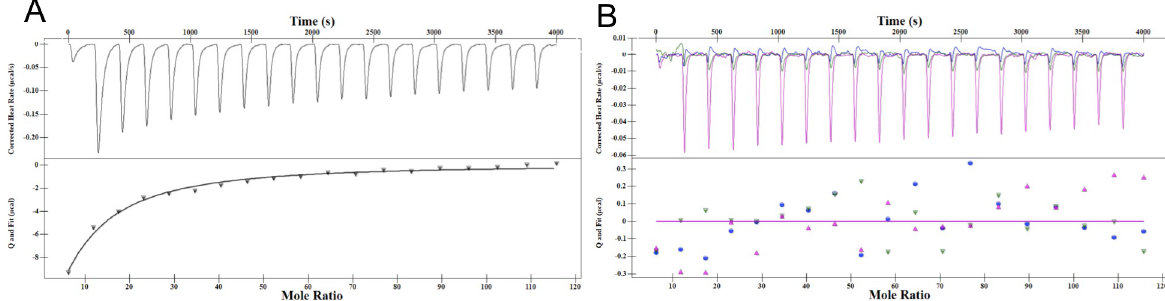
Fig 7. Microscale isothermal calorimetry indicates EfgA binds formaldehyde but not methanol, formate, or acetaldehyde. The binding isotherms represented as heat change ( μ J/s) upon injection over time are in the top portion of the split graph, with independent binding modeling on the bottom portion. (A) Binding observed with 50 μ M EfgA (black) and 2 μ L injections of 25 mM formaldehyde (in PBS). (B) Binding observed with 50 μ M EfgA and 2 μ L injections of 25 mM methanol (blue), formate (green), acetaldehyde (pink). Data are representative of trends observed in multiple experiments ( n = 3); additional replicates are shown in S15 Fig. The original data shown in this and all other figures are available in Supporting information file S1